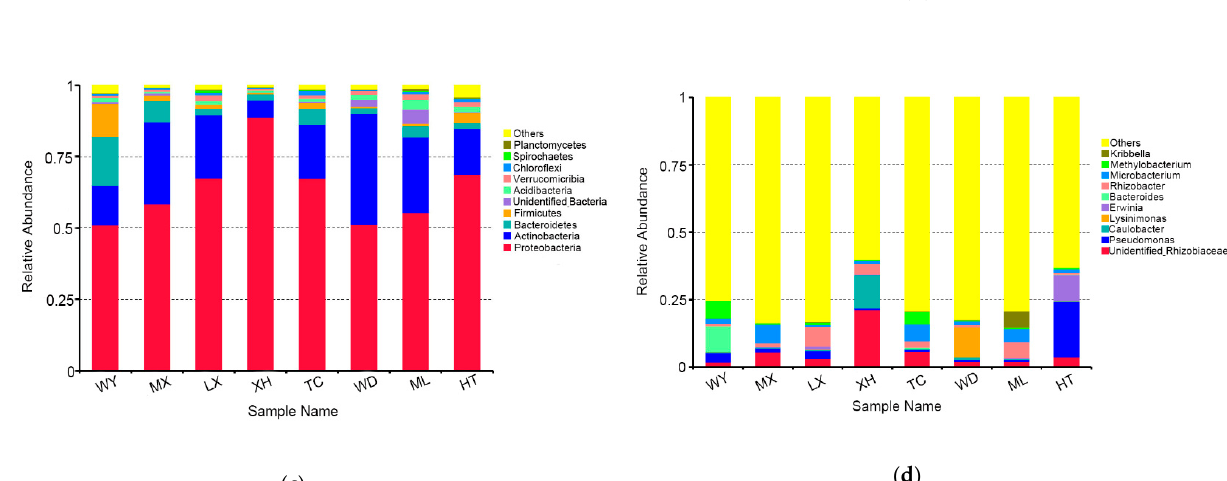
( b ) Figure 5. Variance partitioning analysis (VPA) of geographical versus climate factor on endophytic fungal ( a ) and endophytic bacterial ( b ) community composition. 3.5. Correlation Analysis between Endophytes Diversity and Metabolites of R. palmatum Five secondary metabolites standards of R. palmatum by HPLC as shown in Figure 6, it indicated that five secondary metabolites of R. palmatum can be effectively tested under the condition of this HPLC. Metabolites of R. palmatum differed according to production area (Table 3). Correlation analysis showed that the overall contents of five metabolites were positively correlated with Shannon’s diversity index and Chao1 of endophytic fungi, among which, the specific content of emodin, chrysophanol, and physcion was signifi- cantly positively correlated with endophytic fungal Shannon’s diversity index and Chao1. While the contents of five metabolites were negatively correlated with Shannon’s diver-